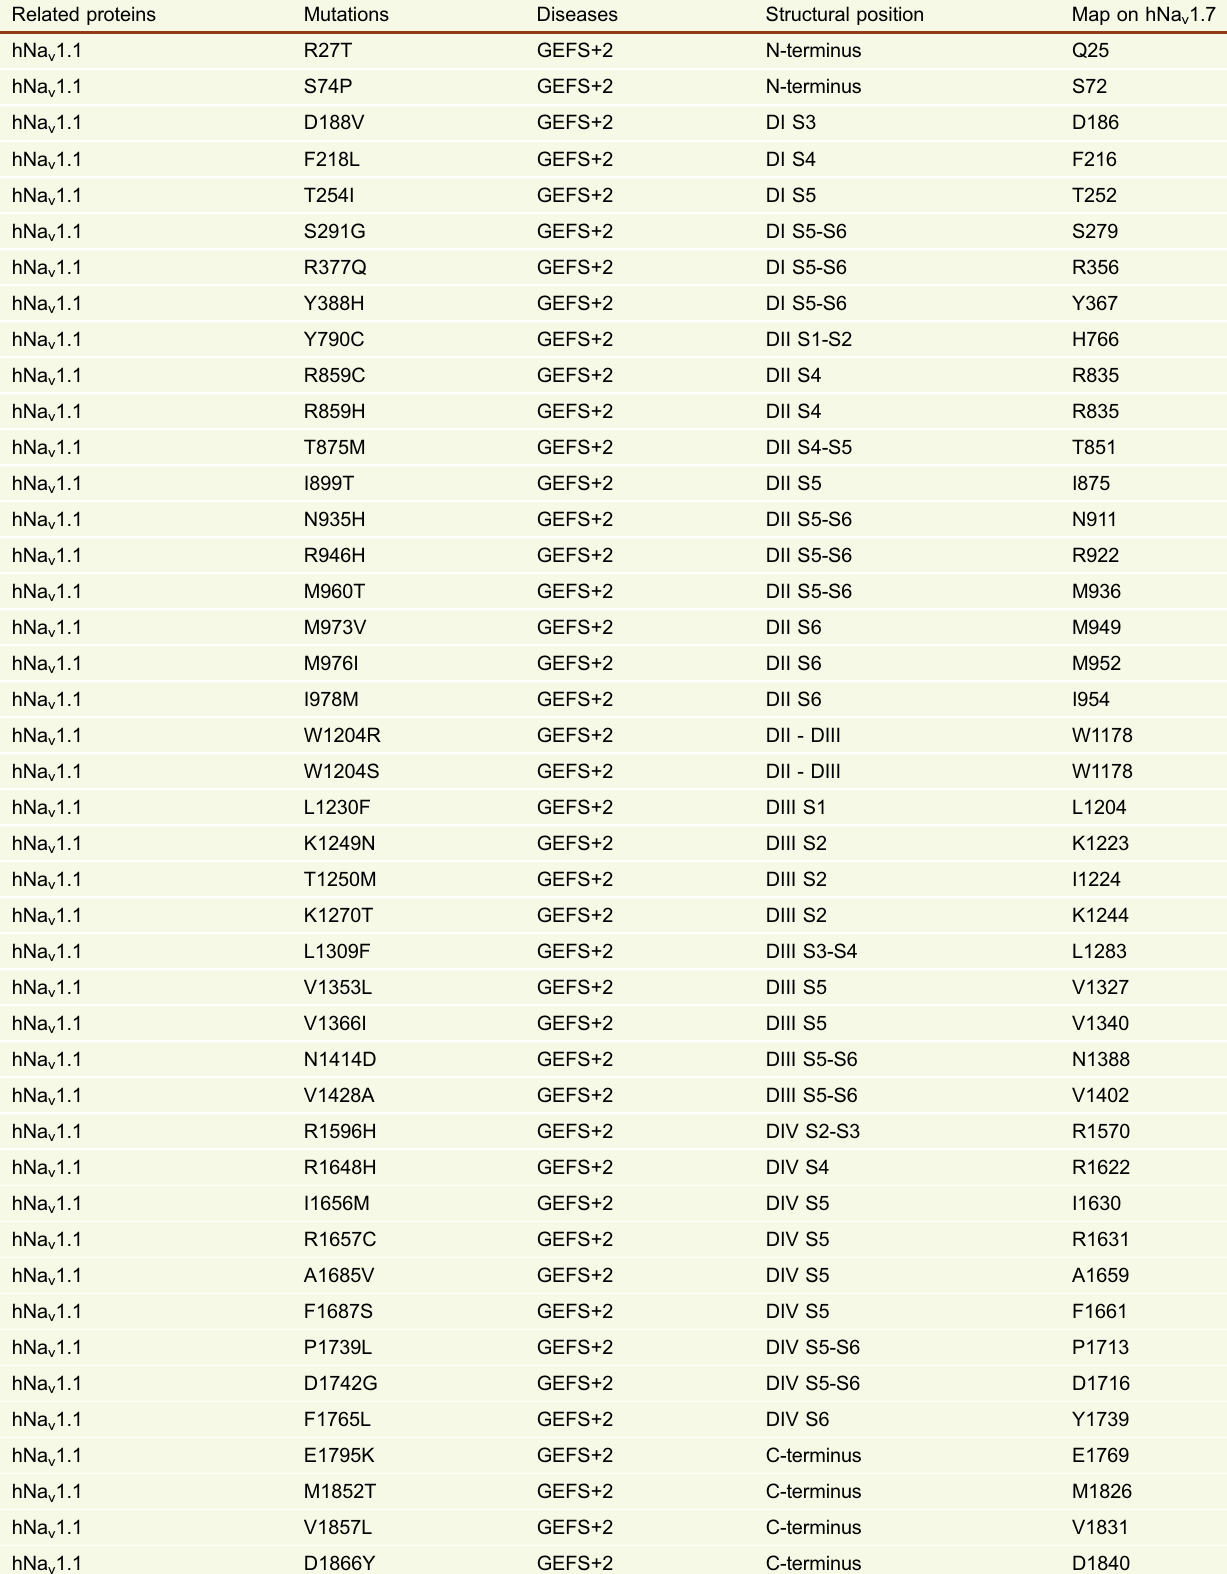
Table 2. Structural mapping of disease-related mutations identi fi ed in human Na v